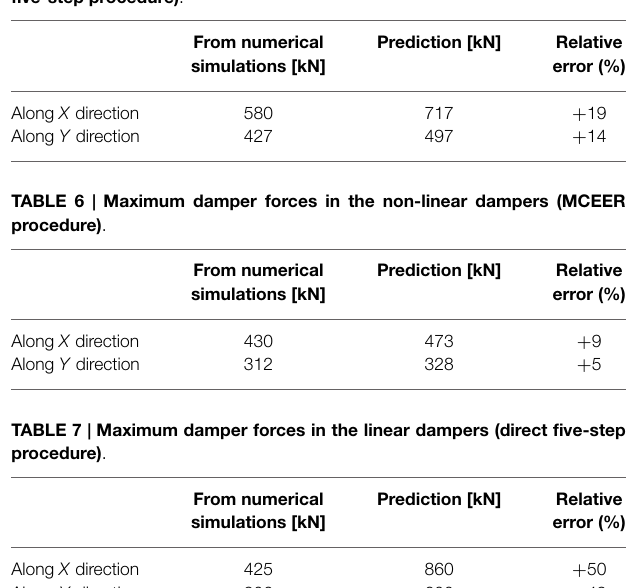
TABLE 5 | Maximum damper forces in the non-linear dampers (direct five-step procedure) .